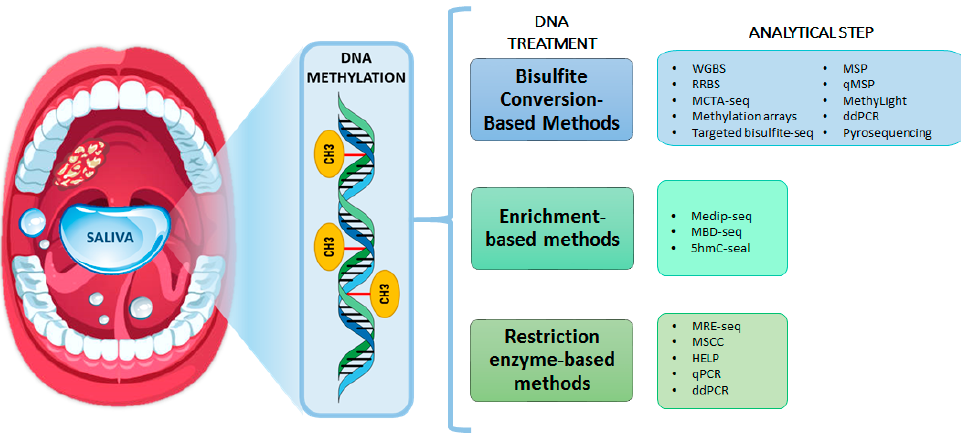
Figure 2. Schematic representation of the technologies for DNA-methylation evaluation.